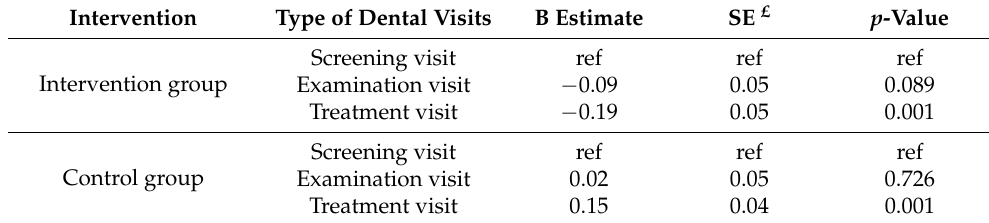
Table 3. Change in CFSS-DS score between visits in each group.